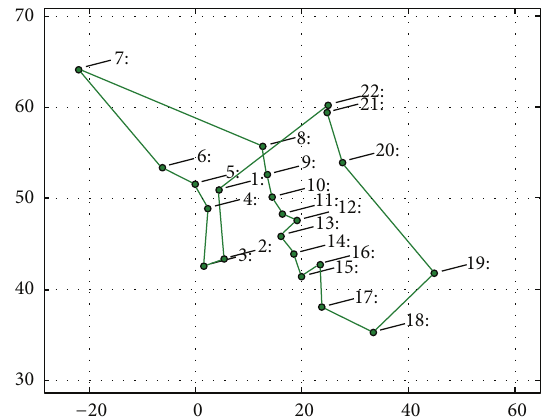
Figure 10: Optimal path is generated for Simulated Annealing in 22